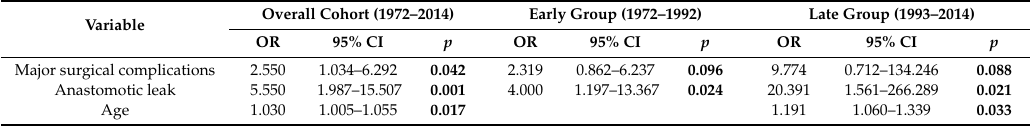
Table 7. Variables associated with postoperative mortality in multivariable